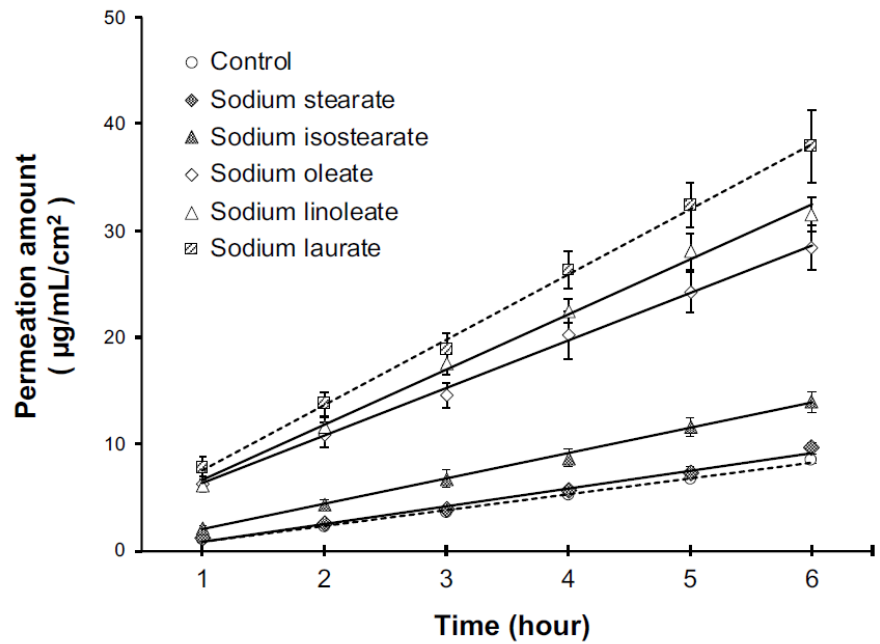
Figure 1. Time-dependent change in the permeation of methylparaben in skin stimulated with each surfactant and control (water). The skin permeation rate of methylparaben from 1 to 6 h was constant, indicating that the skin permeation was in a steady state. Each point value represents mean ± standard error, n = 35 (control), n = 6‒10 (sample).